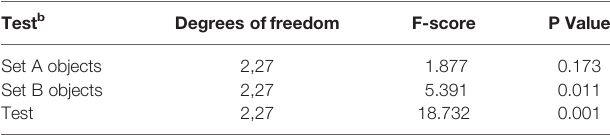
TABLE 2 | MANOVA results for “ What ” , “ Where ” , and “ When ” time spent exploring objects a .